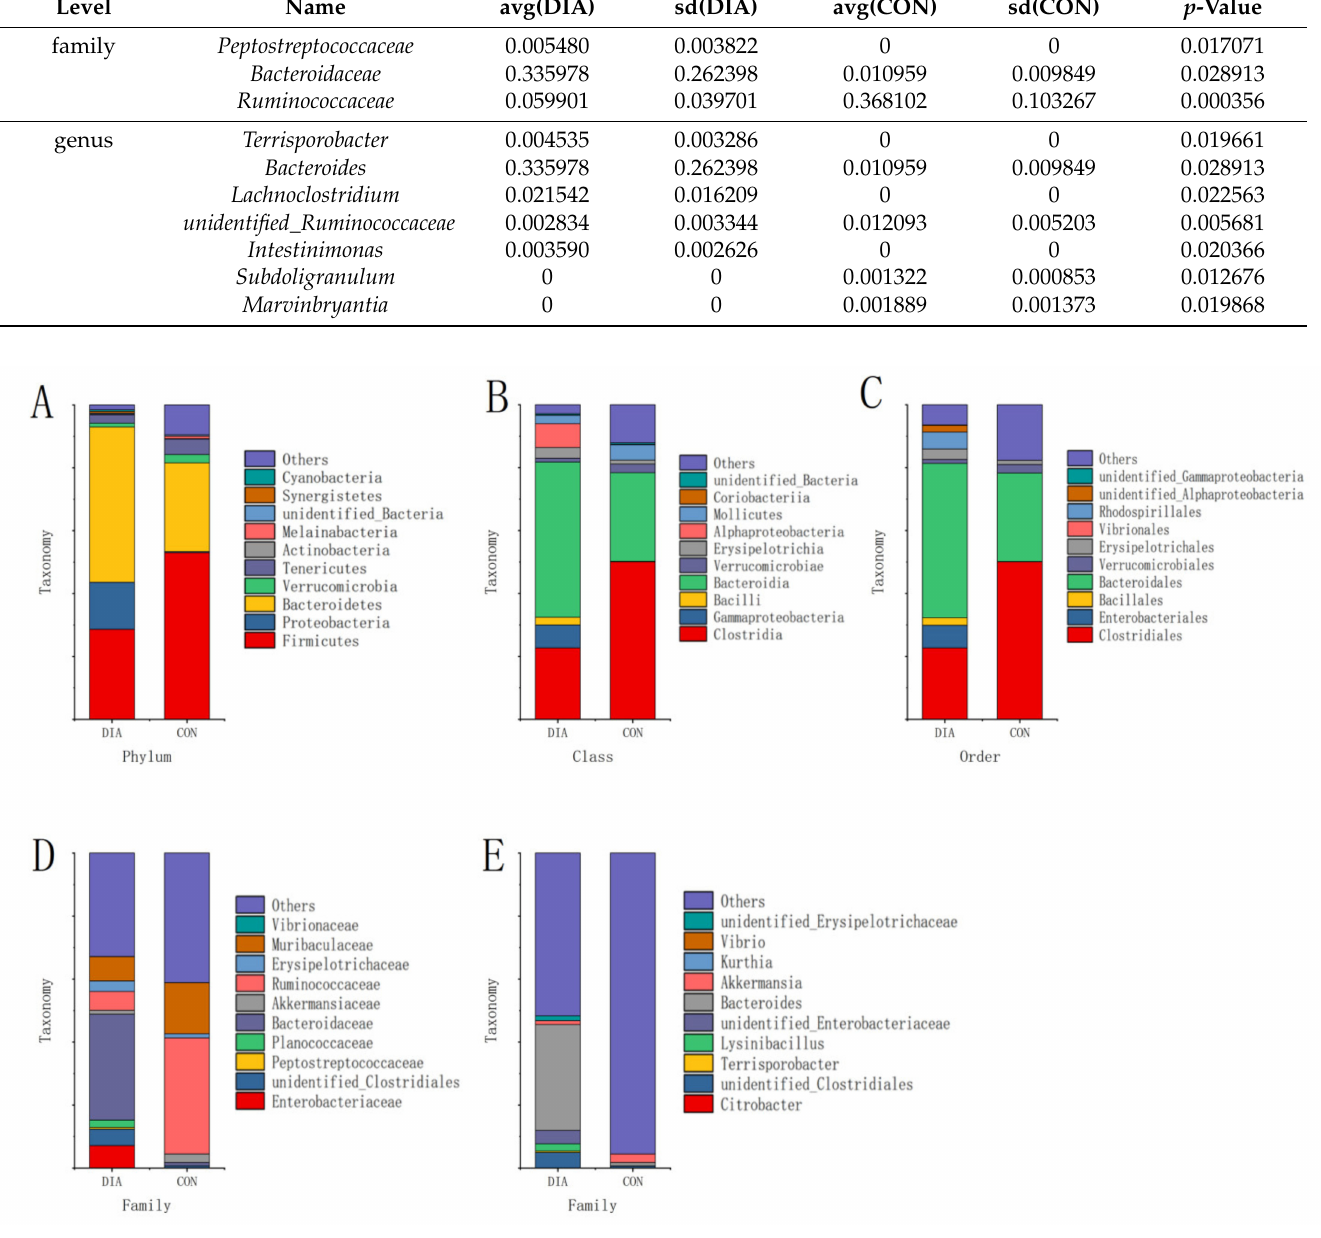
Figure 2. Average relative abundances histogram of species at phylum level ( A ), class level ( B ), order level ( C ), family level ( D ), genus level ( E